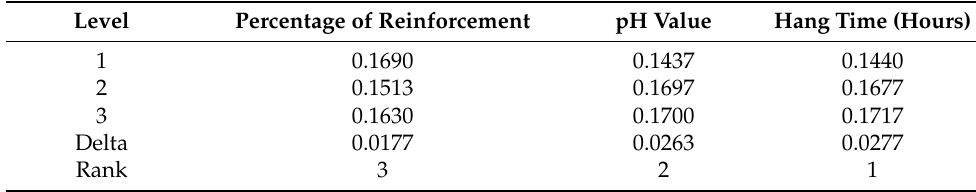
Table 15. Response table for means (corrosion test).